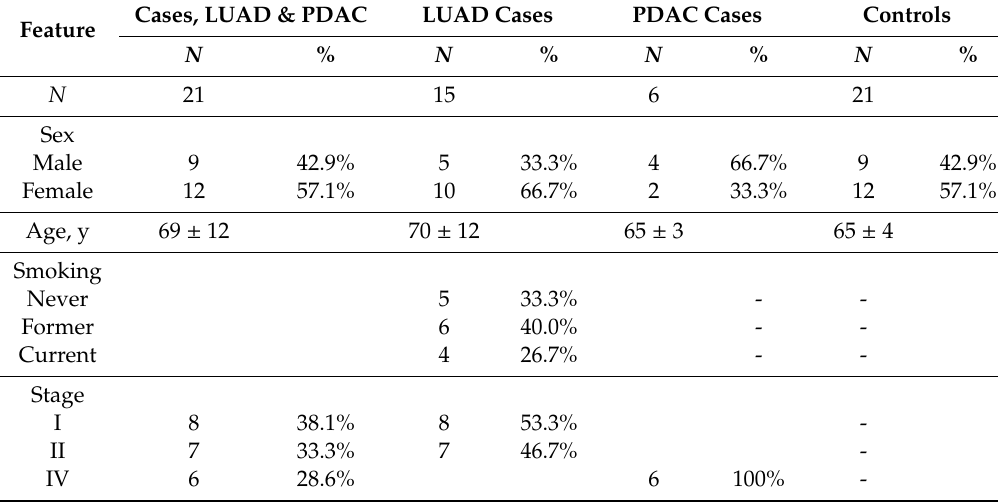
Table A5. Clinicopathological features of lung and pancreatic ductal adenocarcinoma case and control plasma cohorts.